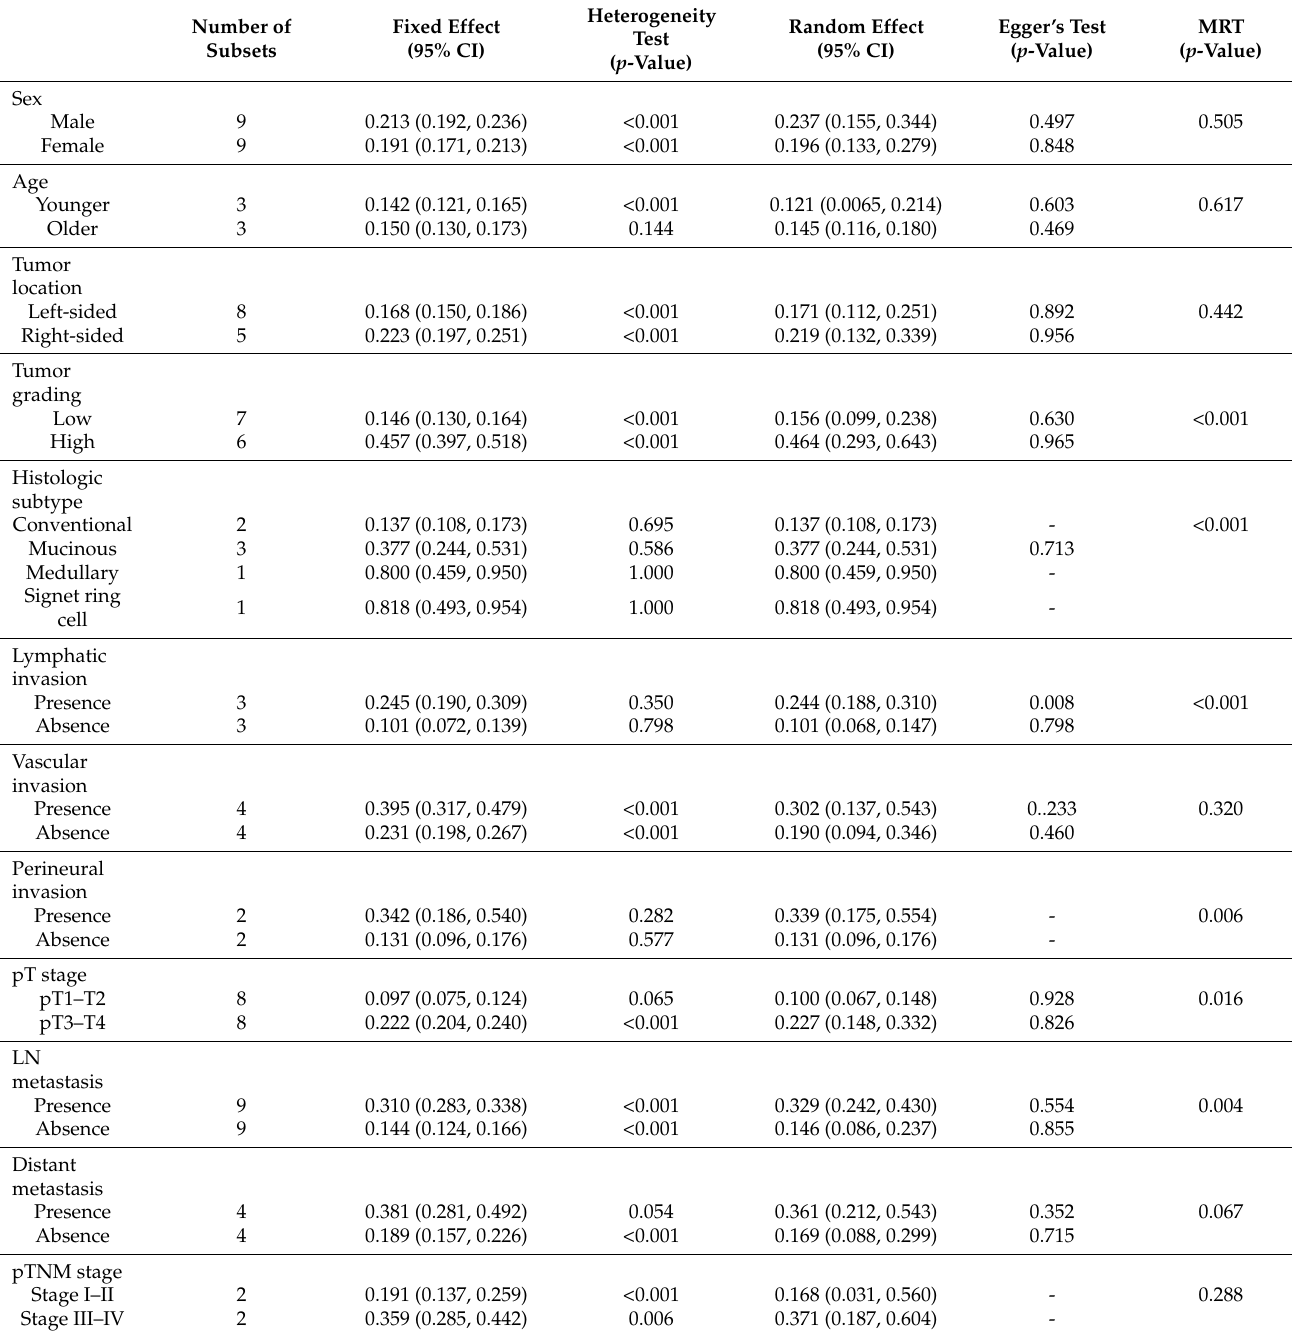
Table 3. Clinicopathological significances of colorectal cancers with intratumoral